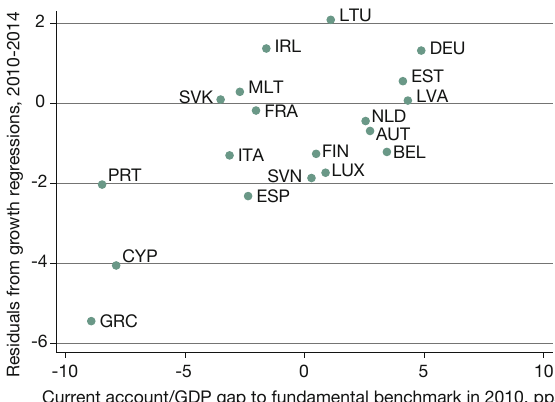
Current account/GDP gap to fundamental benchmark in 2010,